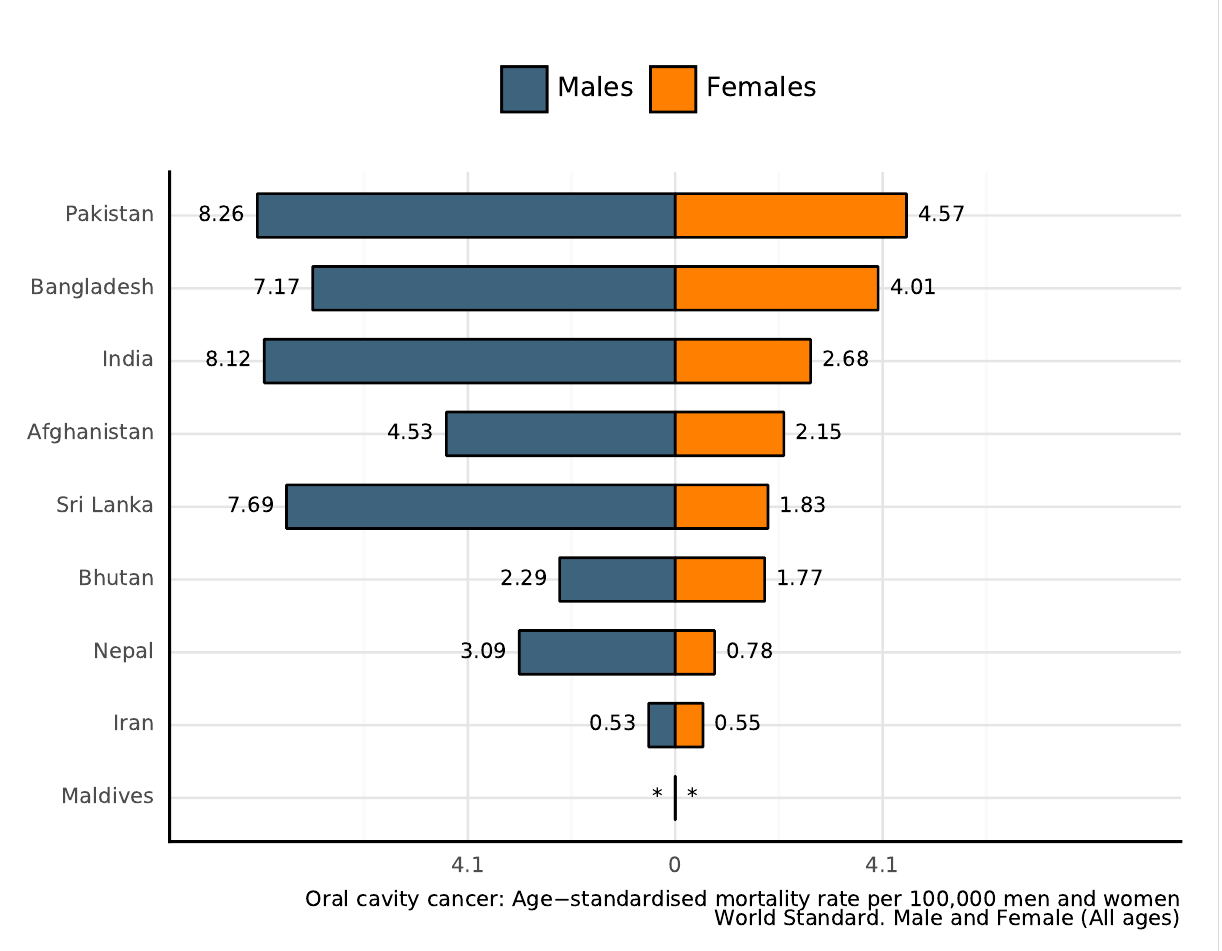
Figure 127: Age-standardised mortality rates of oral cavity cancer of India (estimates for 2020)